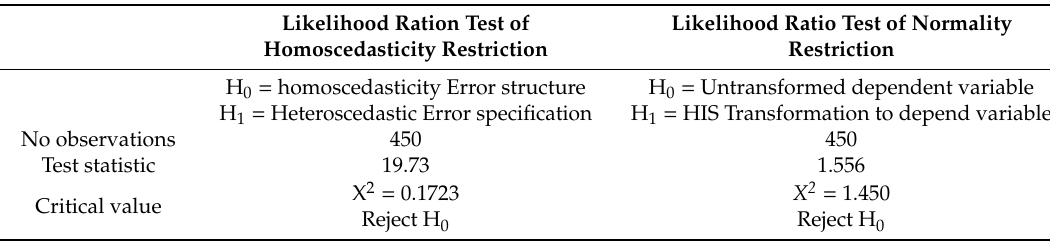
Table A1. Maximum Likelihood Ratio